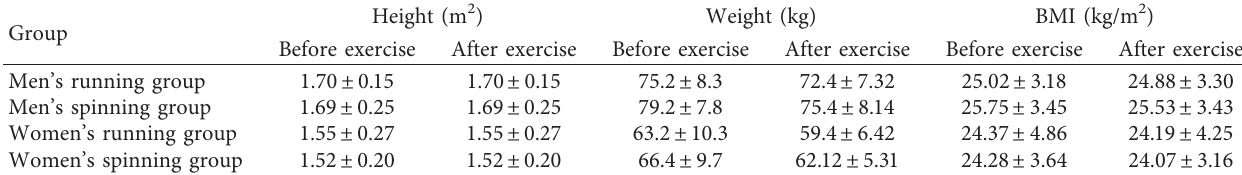
Table 2: Changes in body index of patients with dyslipidemia before and after exercise. Group